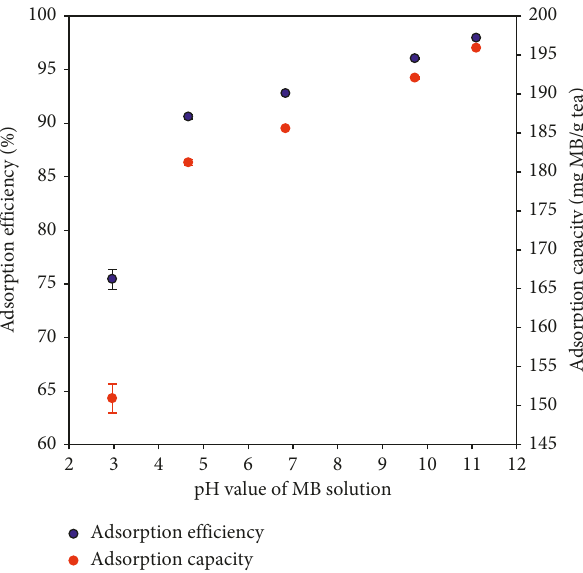
Figure 7: Effect of pH of MB solution on the adsorption efficiency and capacity of